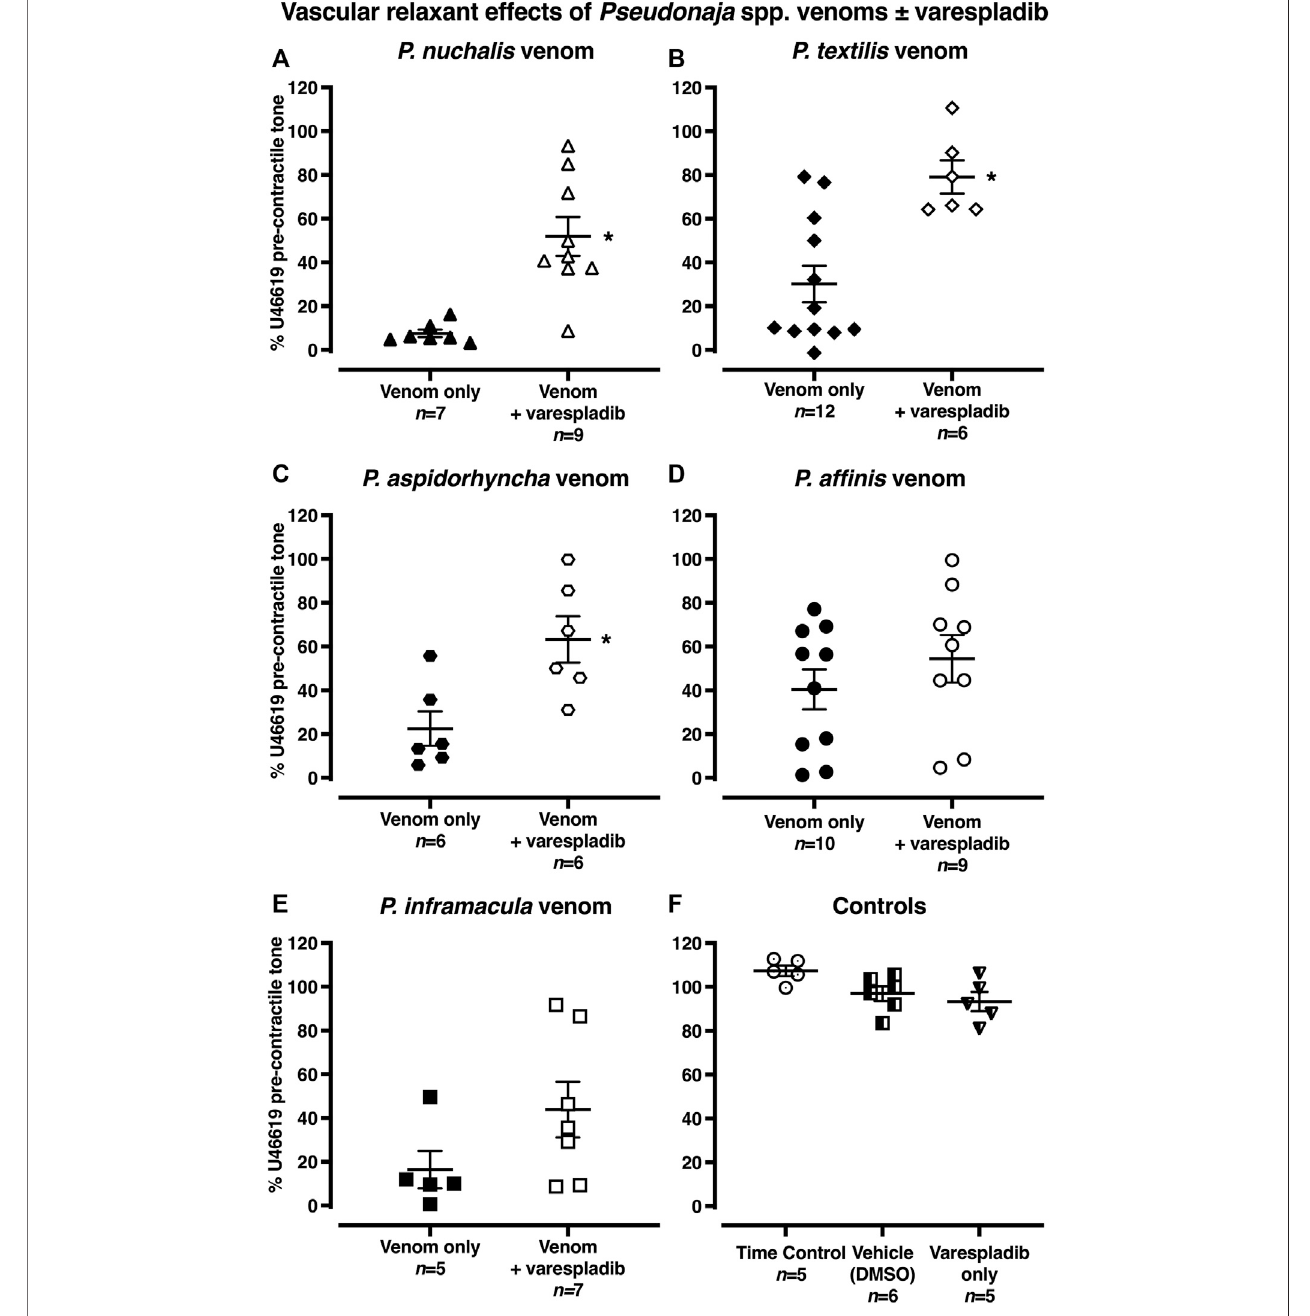
vehicle (DMSO)-arteries were only treated with DMSO (0.1% in bath); or varespladib only-arteries were treated only with varespladib (1 µM in 0.1% DMSO in bath). Horizontal bars are mean and vertical bars ± 1 SEM of n arteries from separate rats. * p < 0.05 vs the respective venom only group, Student ’ s unpaired t test.